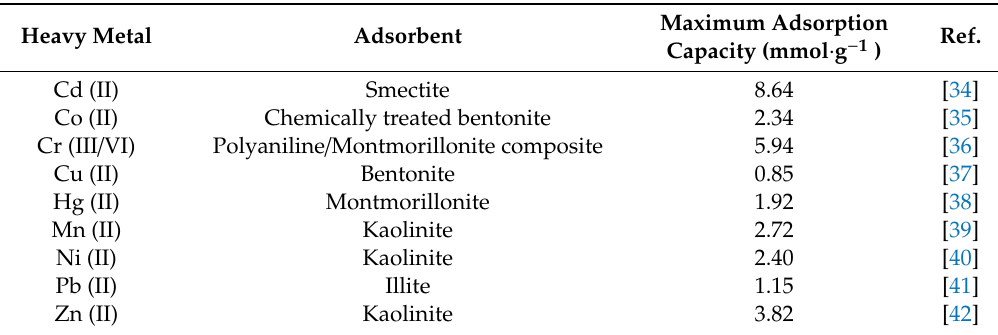
Table 1. Maximal adsorptive e ffi ciency of di ff erent phyllosilicates towards a variety of metal cations